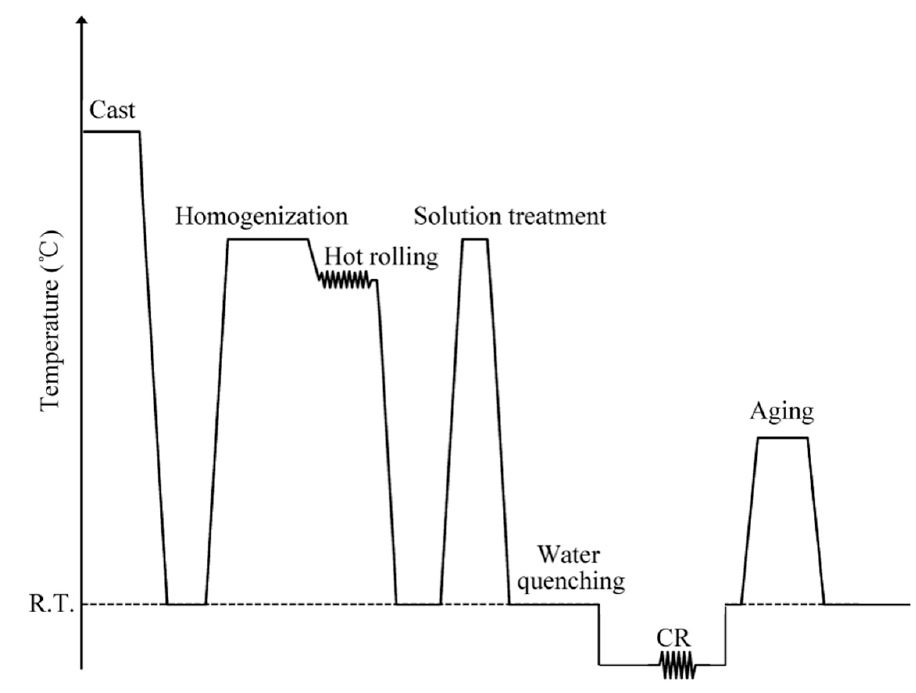
Figure 2. Thermo-mechanical treatments of the designed CuNiSiCr alloys.